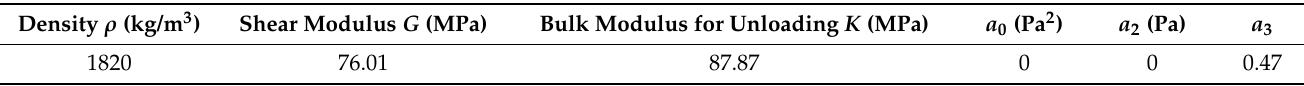
Table 6. Key parameters of the soil layer.